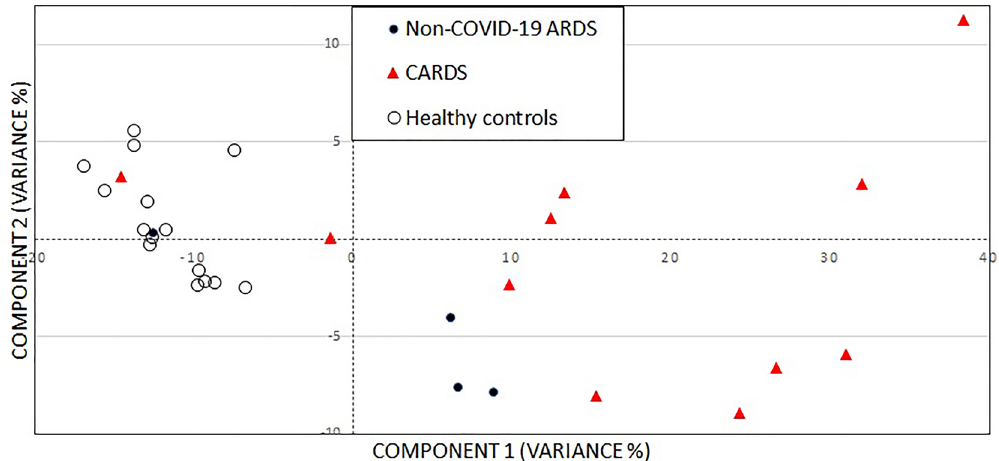
Figure 2. A principal component analysis (PCA) score plot with projection of the data onto the span of the principal components (PC). The spectral matrices were decomposed into two principal components (PCs) by applying singular value decomposition, resulting in a score plot of the first and second PC. Each PC is a linear combination of the wavenumbers of spectra. Before applying PCA, the spectra were baseline corrected (Whittaker smoother) and subsequently normalized by applying standard normal variate methods to avoid intensity variations in the spectra due to the deposition. Two parameters, lambda (λ = 10 5 ) and penalty ( P = 10 –3 ) are involved related to the smoothness of the fit and the penalty imposed to the points giving positive residuals in the